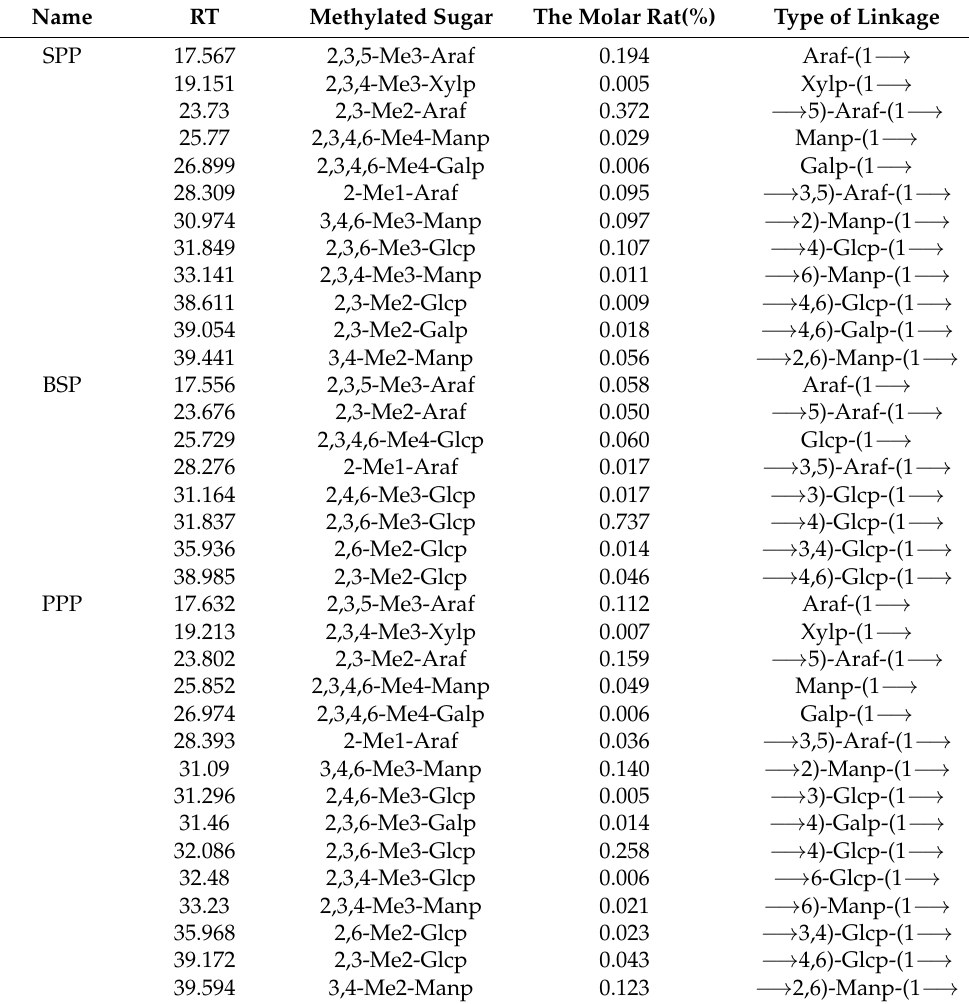
Table 1. Methylation analysis of SPP, BSP, and